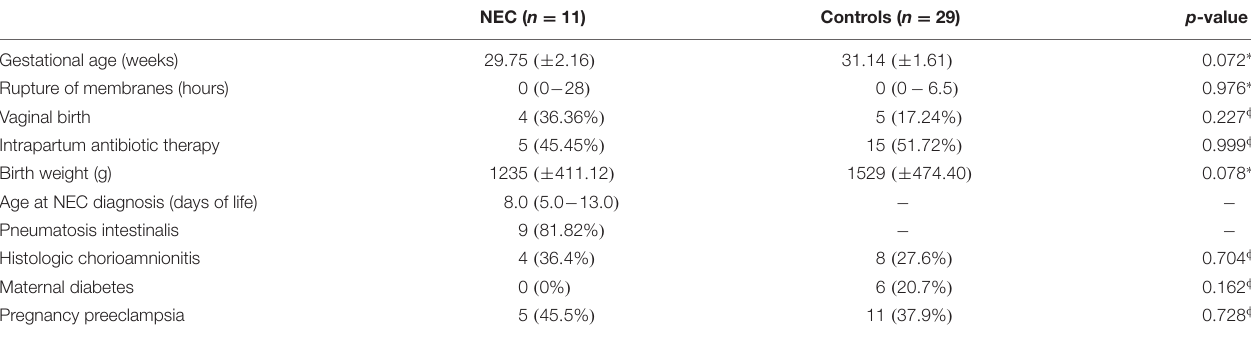
TABLE 1 | Characteristics of the studied